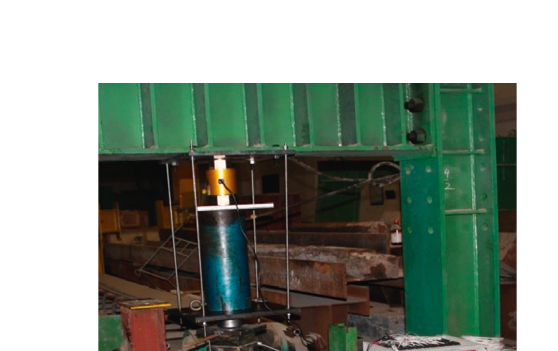
Figure 4: Details of test